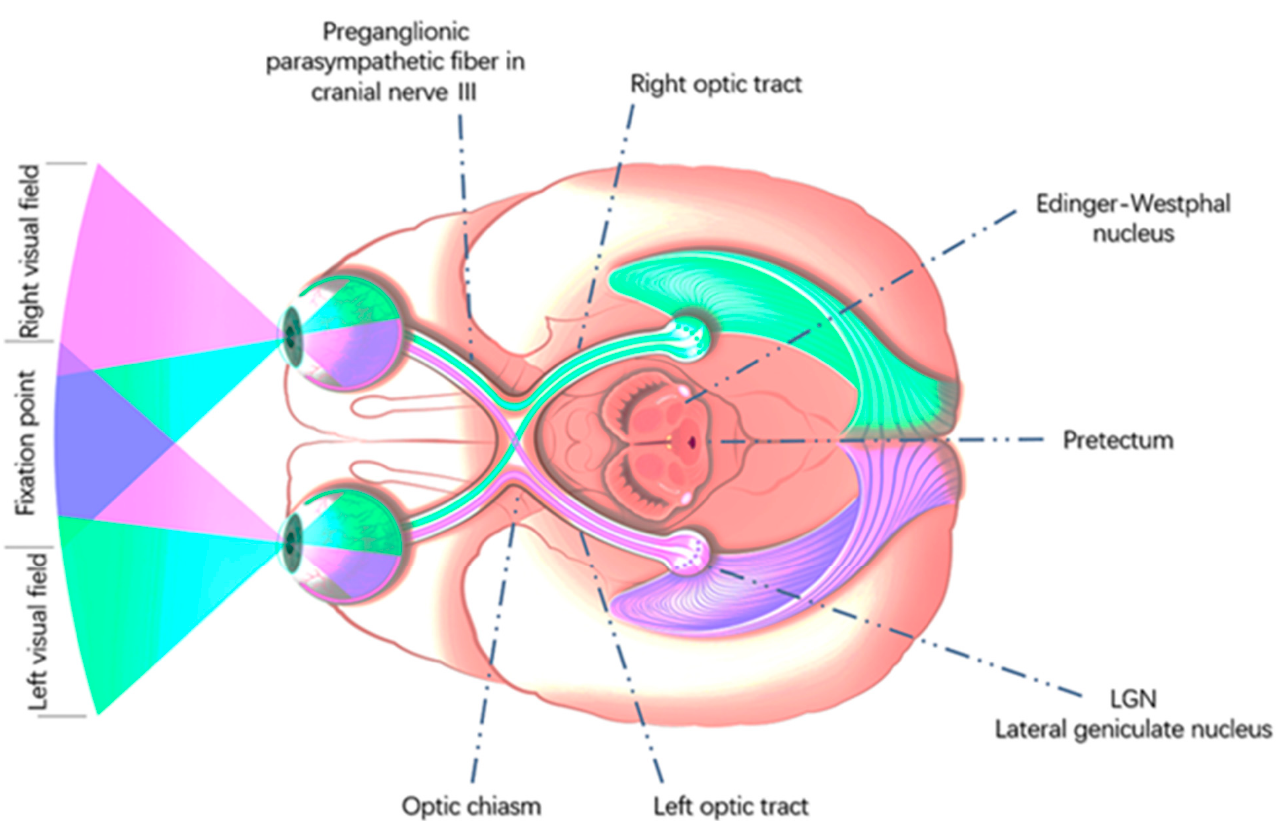
Figure 2. Human visual pathways. Copyright citation: This image is licensed by Eduards Nor- maals.